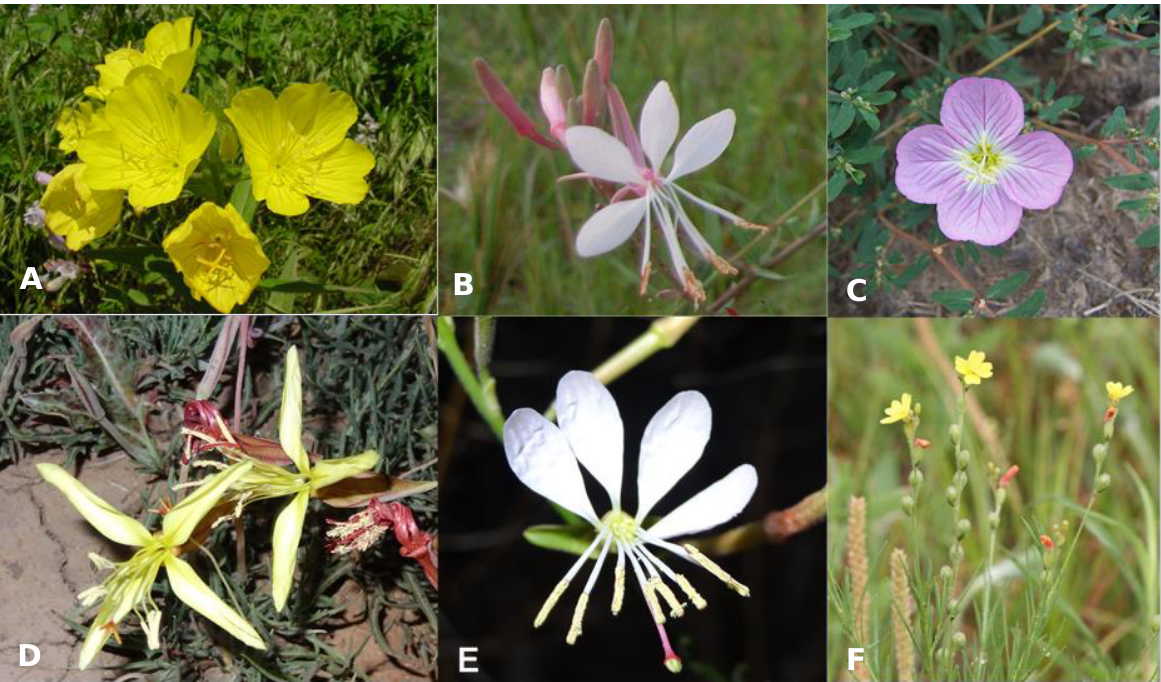
F IGURE 1. A visual overview of the floral trait diversity within Subclade B of Oenothera. A. Oenothera pilosella B. Oenothera dodgeniana C. Oenothera speciosa D. Oenothera havardii E. Oenothera nealleyi F. Oenothera linifolia. Photographs provided by K. N.